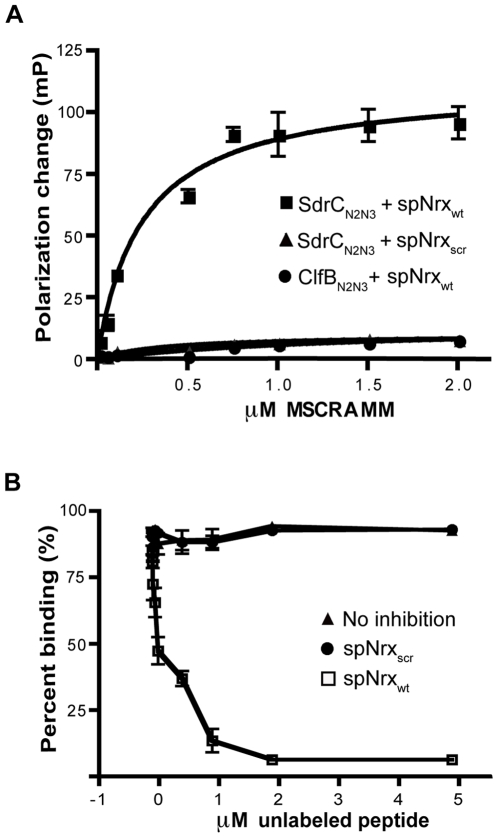
Determination of equilibrium constant of binding.(A) SdrCN2N3 binds specifically to β-neurexin 1. Increasing concentrations of SdrCN2N3 or ClfBN2N3 (black circle) were incubated with 10 nM fluorescein-labelled spNrxwt peptide (black square) or spNrxscr peptide (black triangle) for 3 hours at room temperature in the dark. Equation ΔP = ΔPmax [protein]/(KD+[protein]) was used to calculate the equilibrium constant. The values from three experiments returned a KD = 2.50±0.49×10−7 M. (B) SdrCN2N3 (0.5 µM) (black triangle) was incubated with increasing concentration of unlabelled spNrxwt peptide (white circle) or spNrxscr peptide (black circle) at room temperature. After 3 hours, the mixture was incubated for another 3 hours at room temperature in the dark with 10 nM fluorescein labeled spNrxwt peptide. Fluorescence polarization was determined as described above. The values represented here are the mean±SD of triplicates from three experiments.